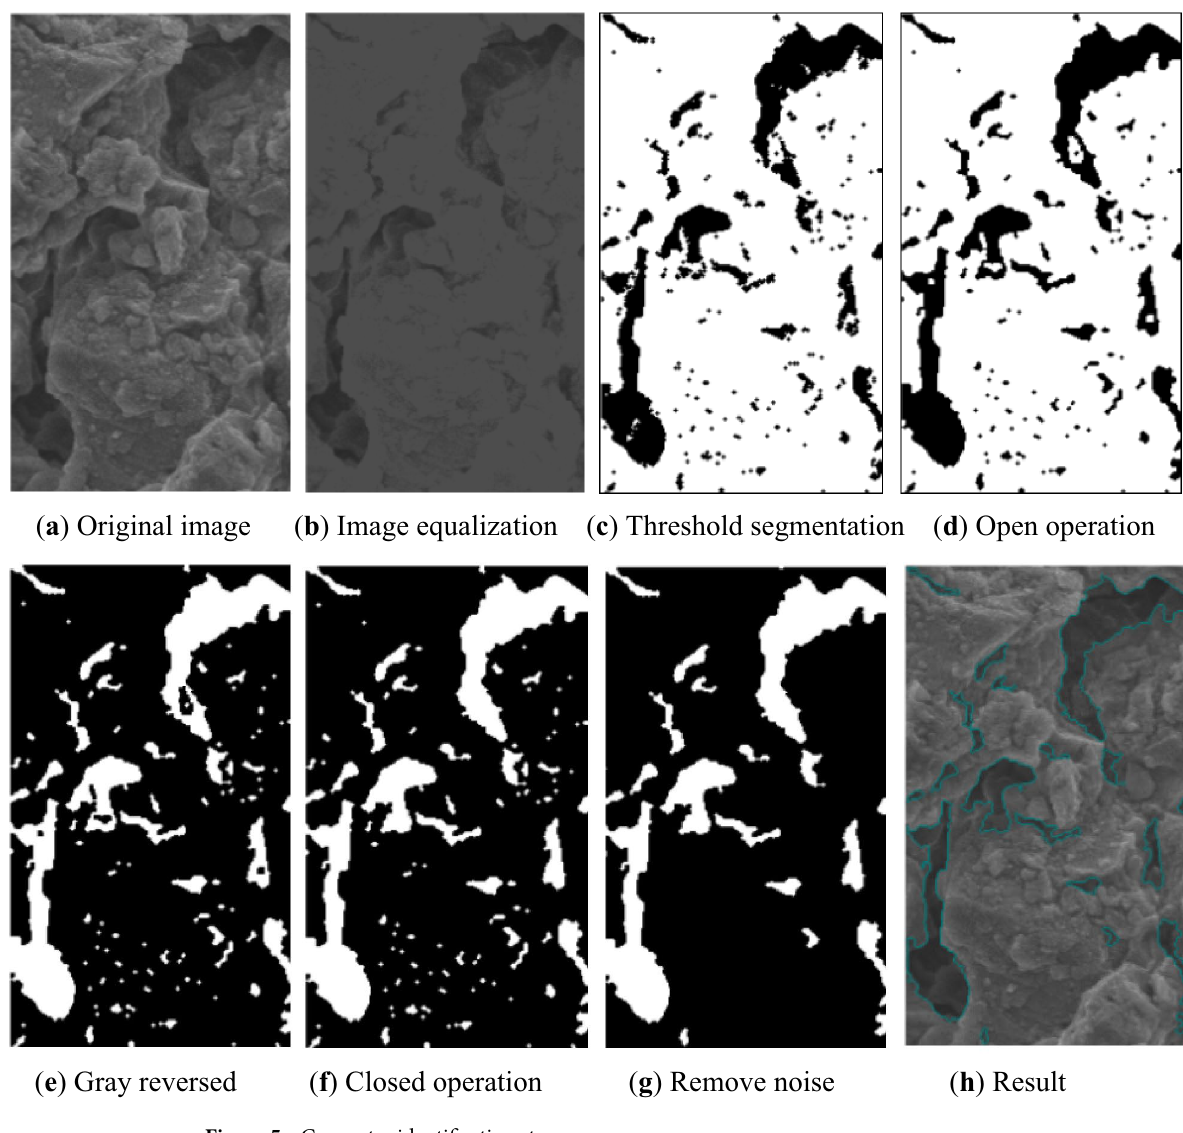
Figure 5. Computer identification